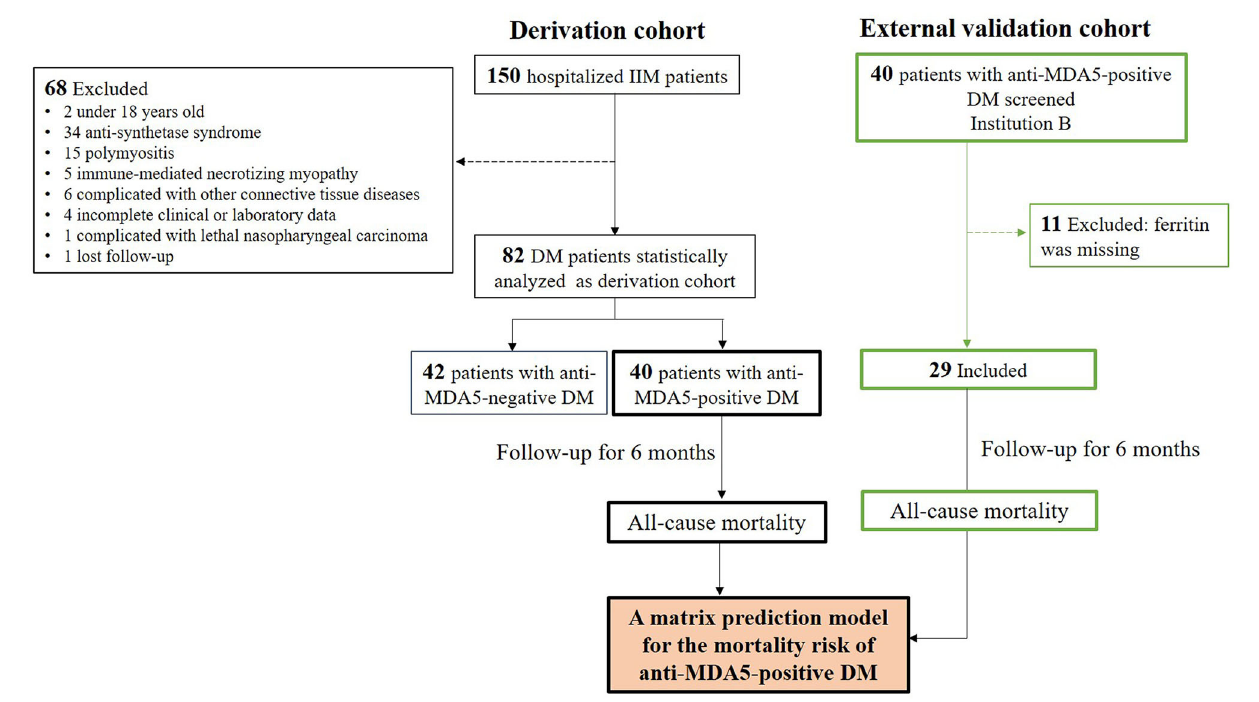
FIGURE 1 | Flow diagram of patients with DM during 6-month follow-up. The derivation cohort was used to develop a matrix prediction model, and external validation cohort from another institution was used to validate the model. IIM, Idiopathic inflammatory myopathy; DM,